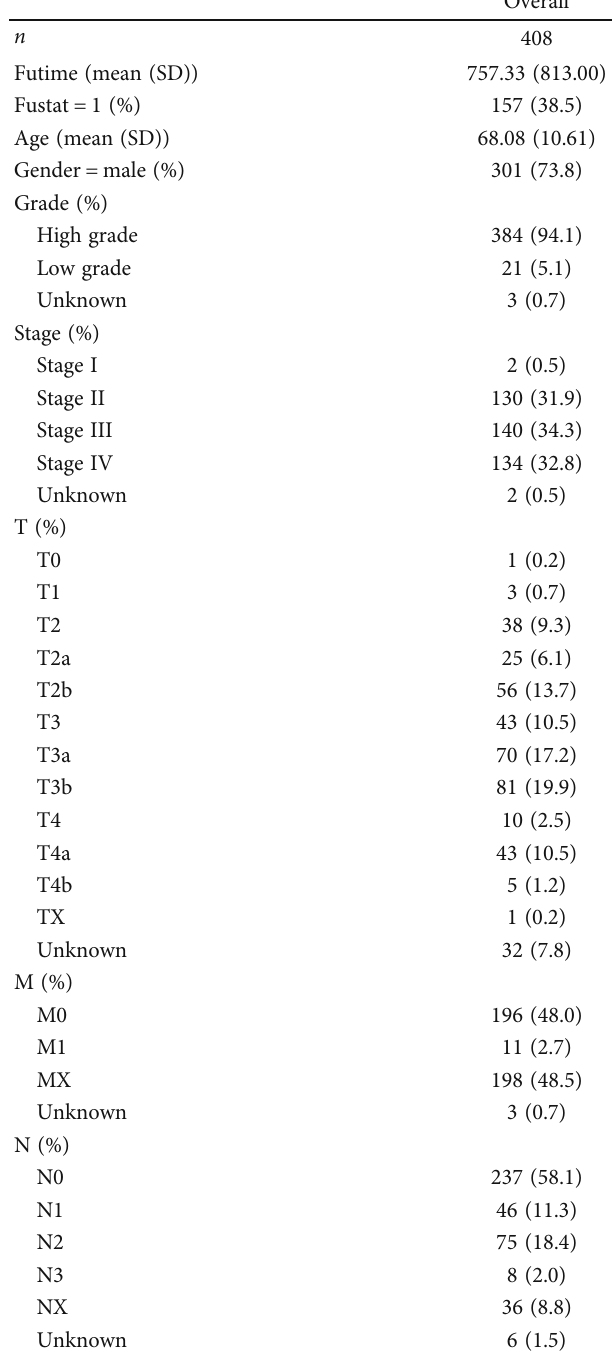
Table 1: Statistics of clinicopathological characteristics of bladder cancer